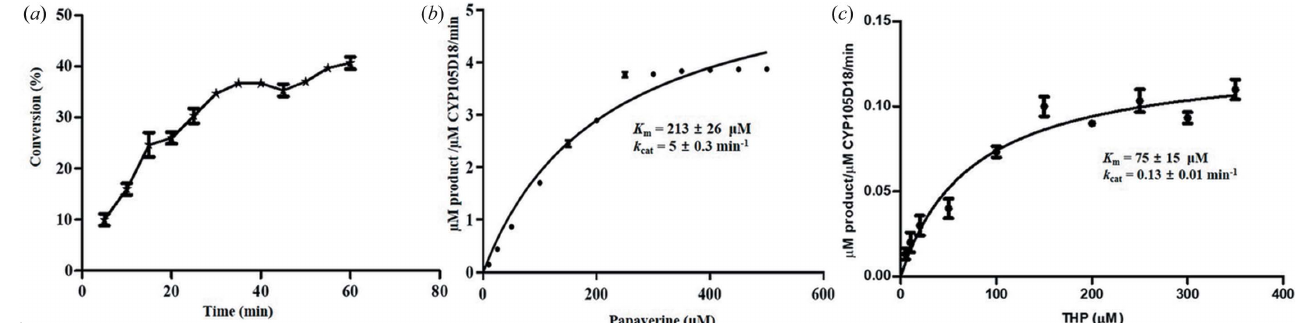
Figure 4 ( a ) Time-dependent conversion of papaverine to papaverine N -oxide. Conversion was measured every 5 min for 1 h using 1 m M CYP. The reactions